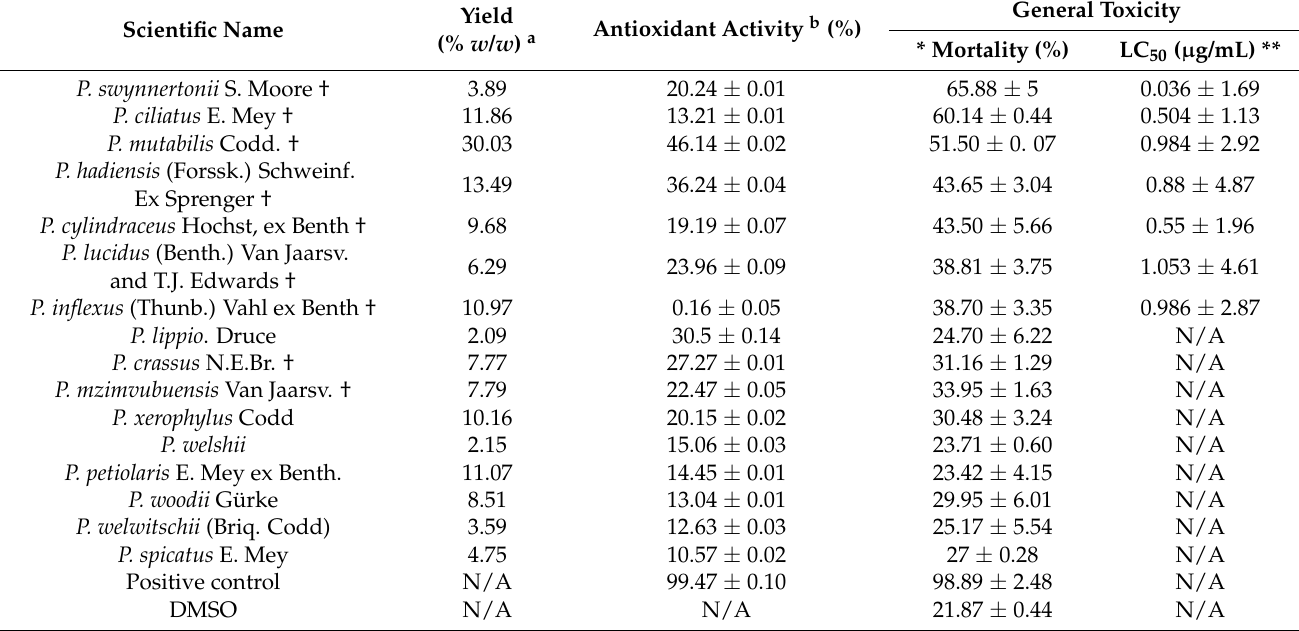
Table 1. Extraction yields (dry weight % w / w ), antioxidant activity, and general toxicity of sixteen Plectranthus spp. acetonic